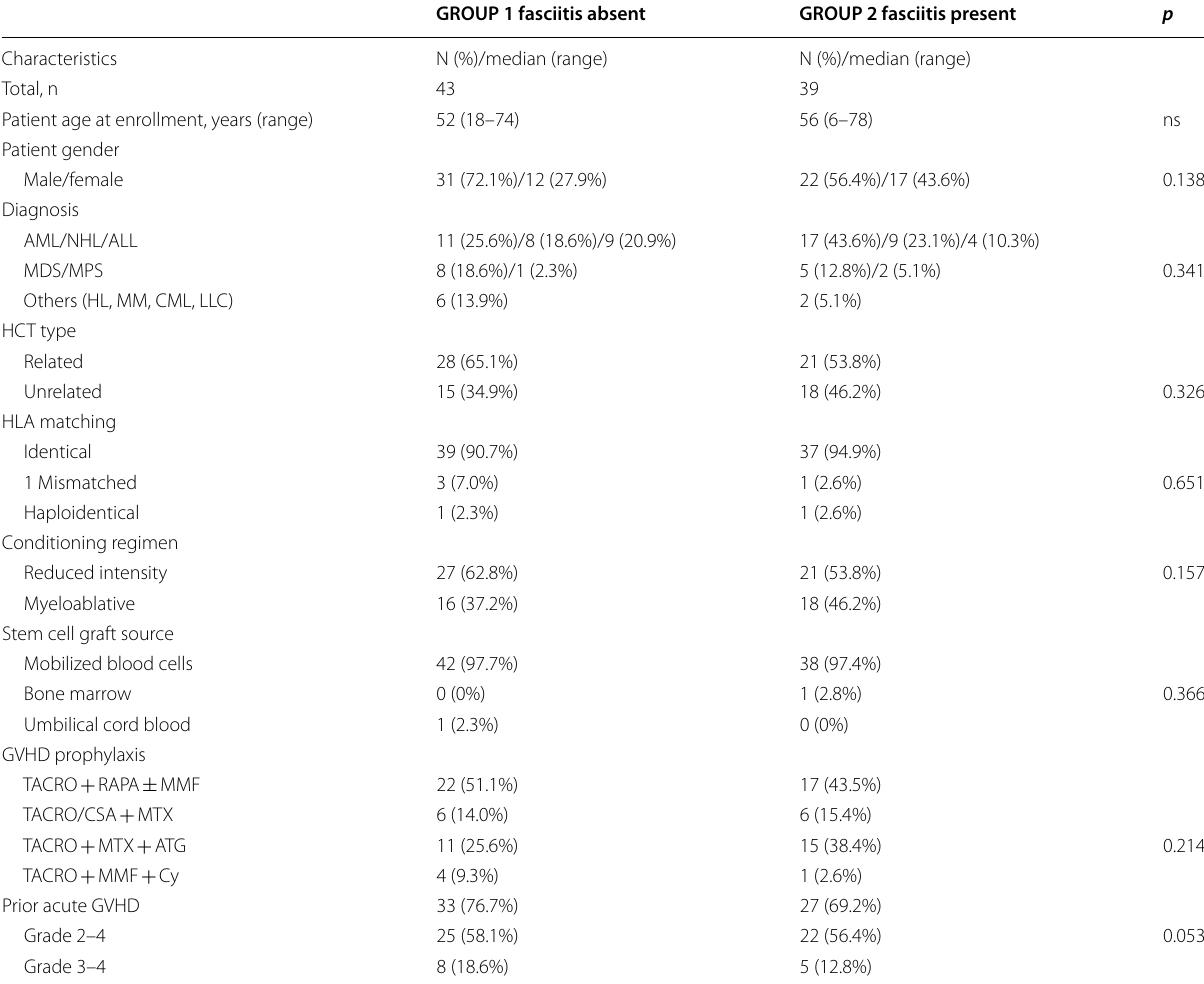
Table 2 Baseline and transplant‑related